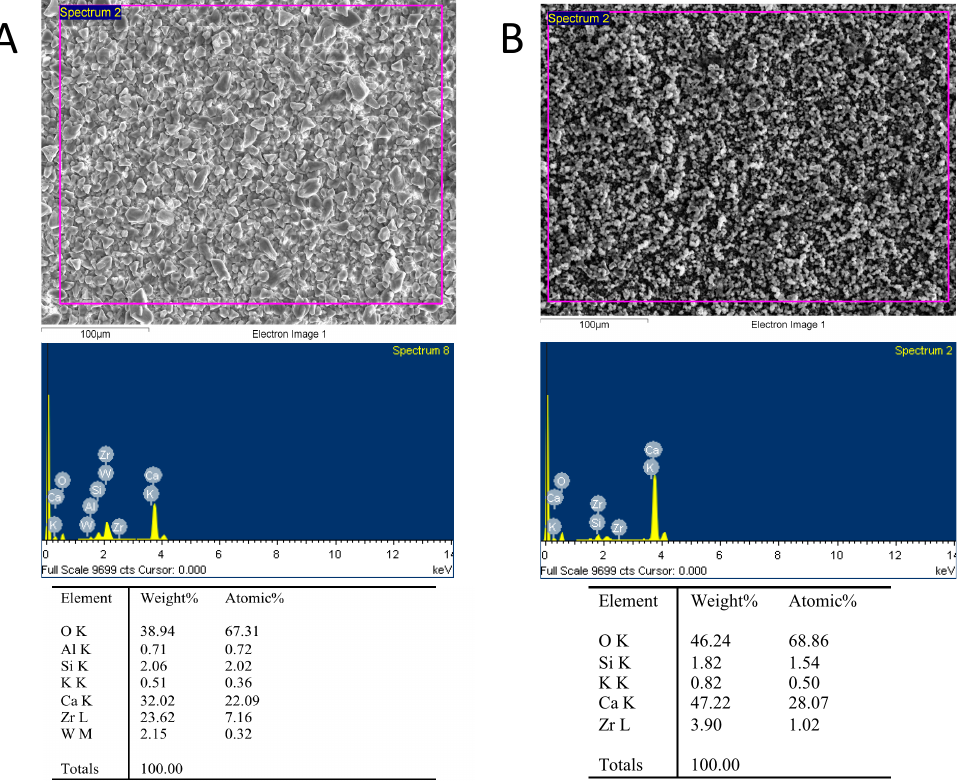
Figure 6. Surface properties and composition of Bio-C Sealer ( A ) and Bio-C Repair ( B ) under scanning electron microscope with energy-dispersive X-ray analysis (SEM-EDX).